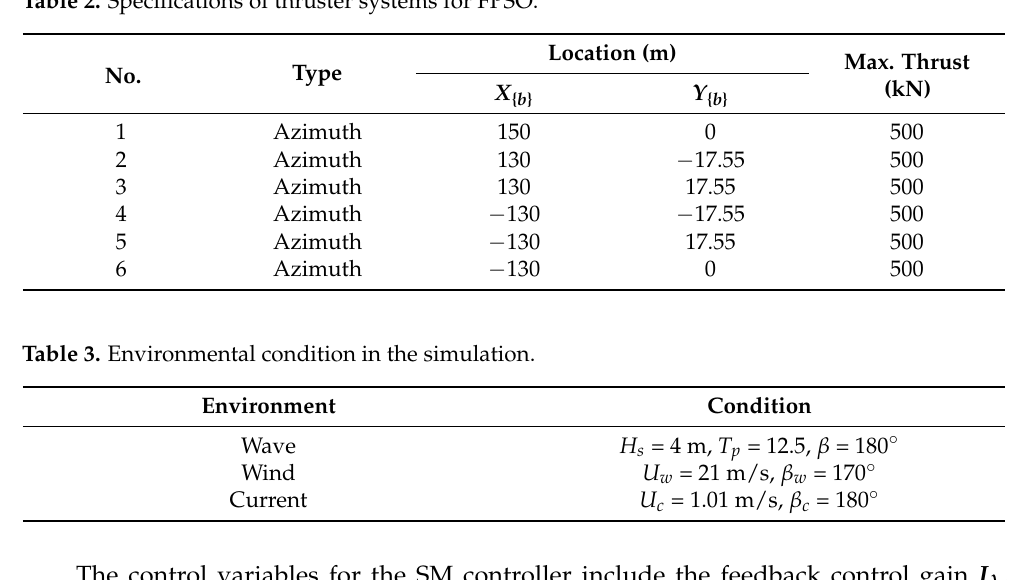
Table 2. Specifications of thruster systems for FPSO.